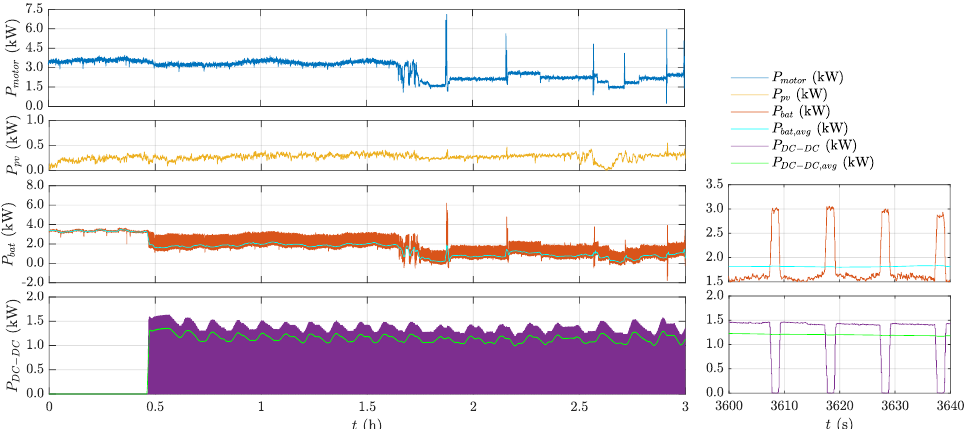
Figure 23. Data acquired during endurance race depicting the motor power, PV power, battery power, and DC-DC converter input power, respectively; and the battery and DC-DC power moving average tested under 10 s of window length. Right-hand plots are the zoomed-in versions of battery and DC-DC